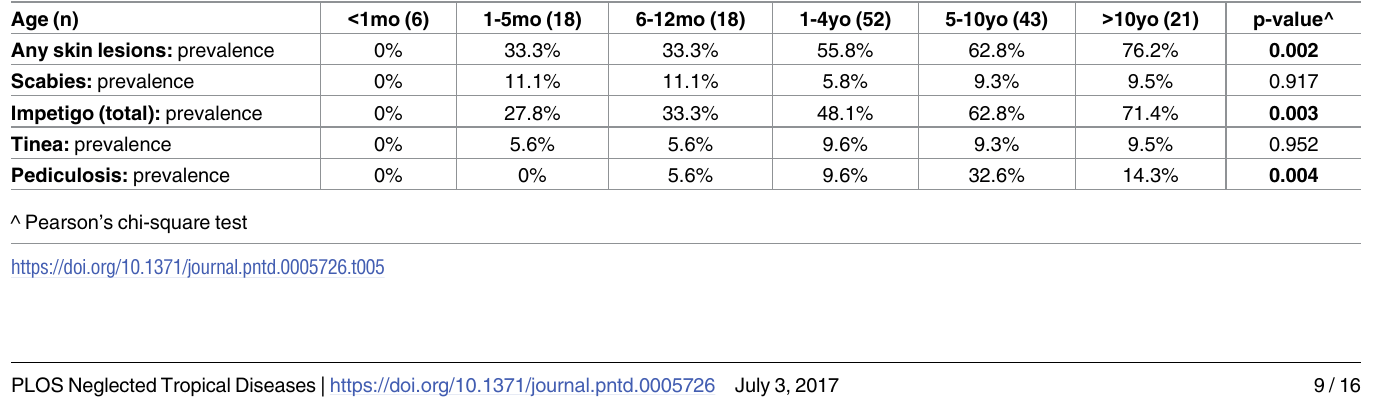
Table 5. Prevalence by age group